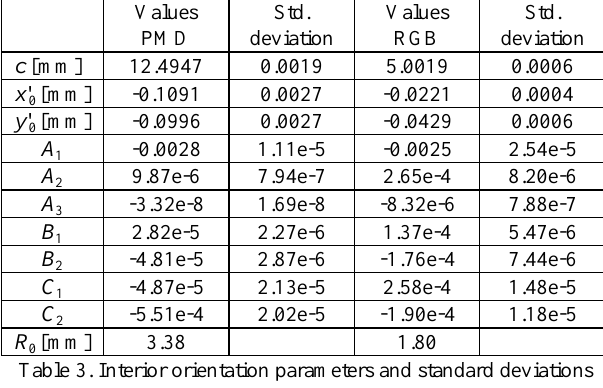
Table 3. Interior orientation parameters and standard deviations